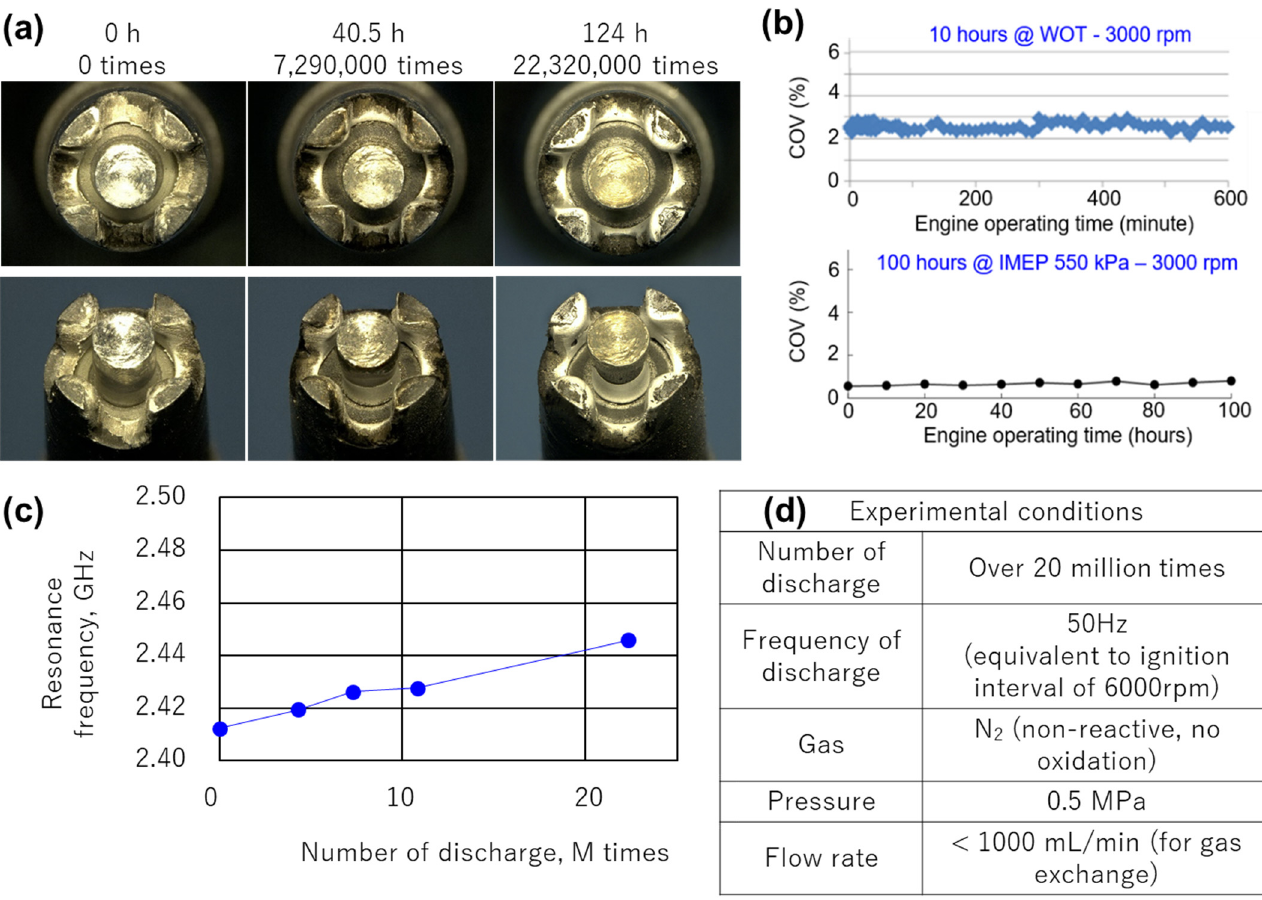
Figure 13. ( a ) Actual images of microwave discharge igniter (MDI) under wide throttle opening (WOT) conditions at 3000 rpm for 0 h (0 ignitions), 40.5 h (7.29 ignitions), and 124 h (22 million ignitions). ( b ) Effects of engine operation time on coefficient of variation (COV) were insignificant. ( c ) Effects of number of discharges to resonance frequency for ( d ) these experimental conditions.